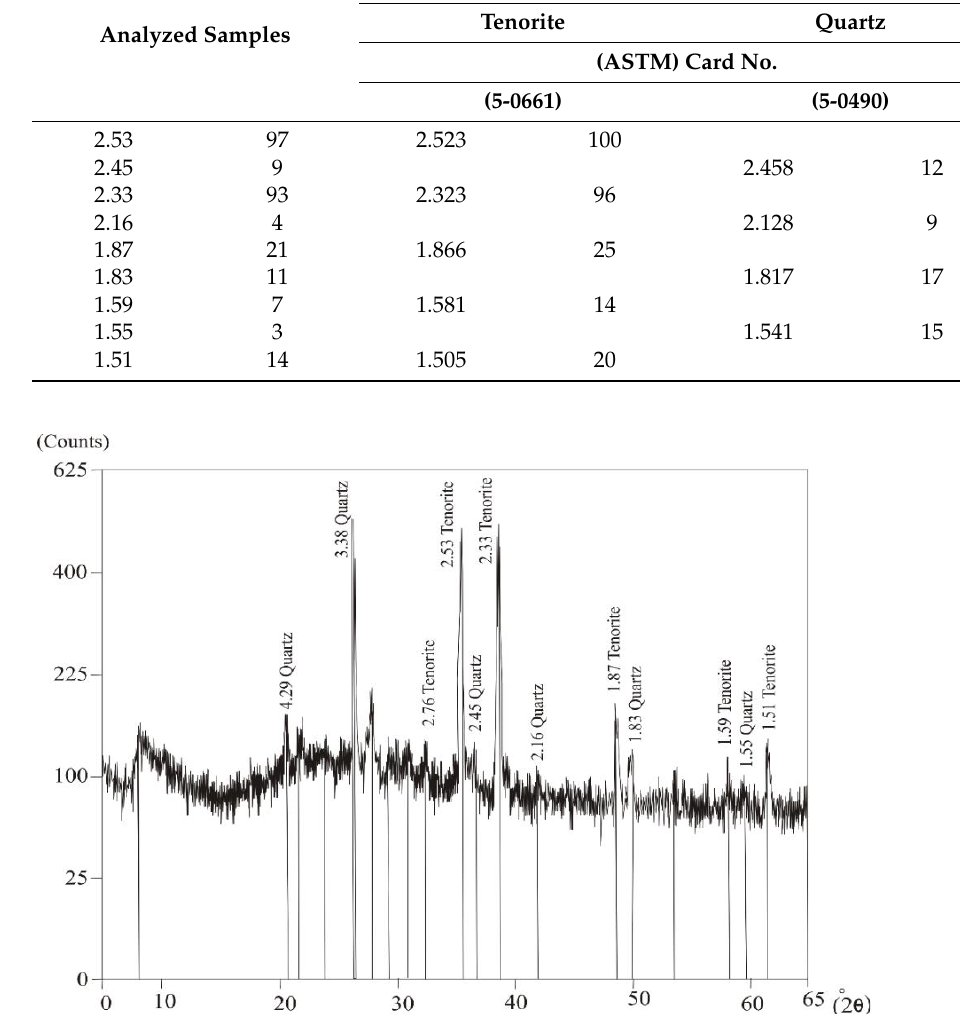
Figure 6. X-ray diffraction (XRD) patterns of tenorite and quartz from monzogranite at Monqul, north Eastern Desert, Egypt. Table 3. Identification of tenorite and associated quartz from monzogranite using X-ray diffraction (XRD) technique at Monqul, north Eastern Desert, Egypt.